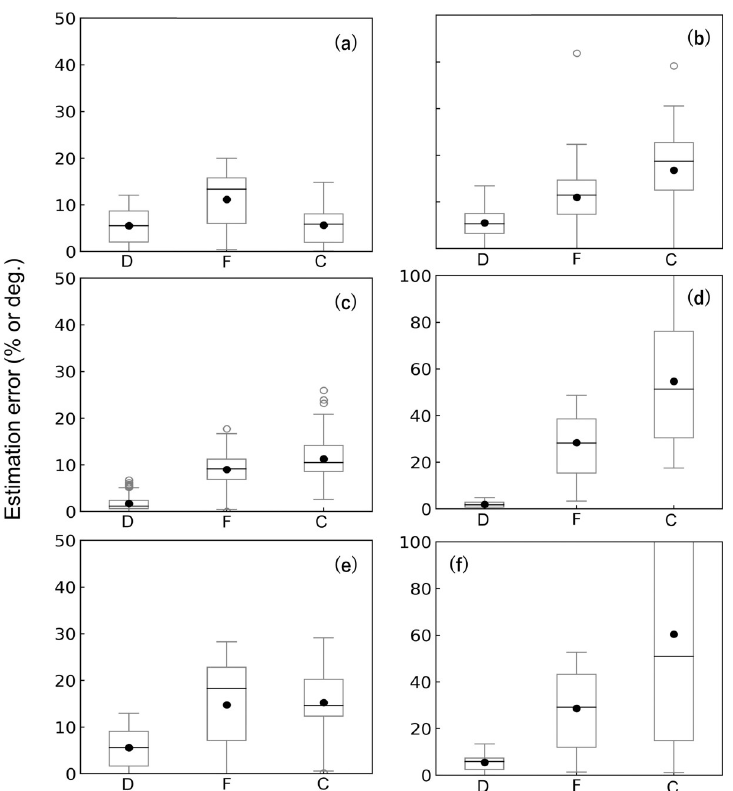
Fig 11. Box plots of all averaged estimation errors for circumferential experiments calculated using parameter assignments other than those used in our method. (a, b) The ‘right-angle’ parameter assignment in which the angle between strain gauges d1 and d2 was assumed to be 90˚ and the forces were estimated based on vector synthesis of outputs from the gauges. (c, d) The ‘common E’ assignment in which we used the average of the modulus of elasticity, E, from each strain gauge for the calculations of F, C, and D. (e, f) The ‘right angle & common E’ assignment is a combination of the first and second methods. Results for the wood pole (a, c, and e) and sapling (b, d, and f). F, the amount of force; C, the center of force; and D, the direction of force at h t . Each black solid circle in the panel shows the average value. For the calculation of the estimation errors, see the caption of Figs 5 and